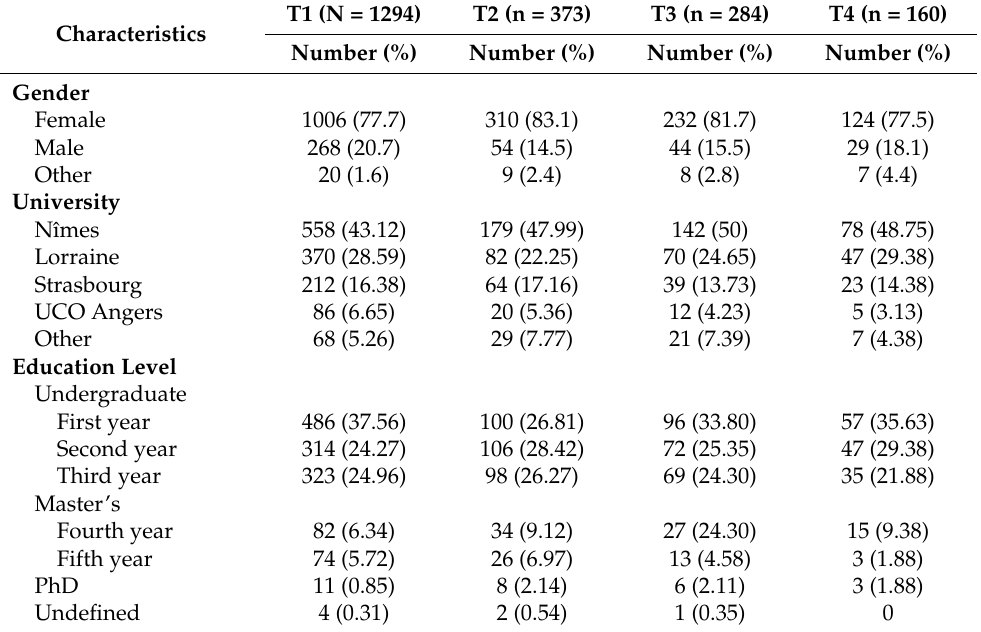
Table 1. Characteristics (numbers and percentages) of all respondents at each measurement